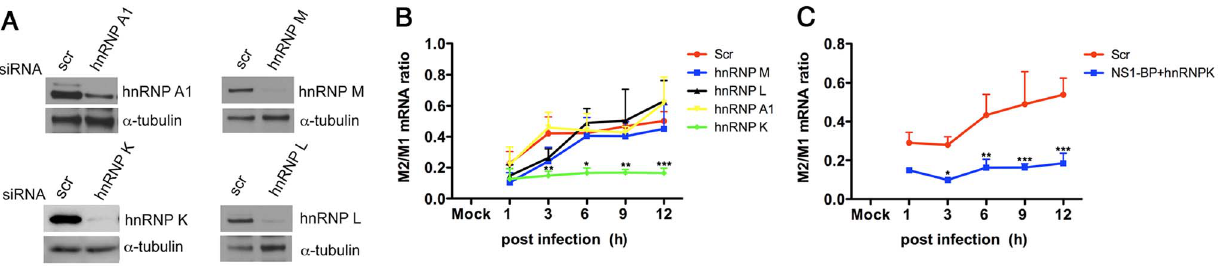
Figure 4. hnRNP K regulates M1 mRNA splicing. (A) Cell extracts from A549 cells transfected with non-targeting siRNAs or siRNAs that target various indicated hnRNPs for 48 h were subjected to immunoblot analysis with antibodies specific to each hnRNP. (B and C) A549 cells were transfected as in B and then infected with A/WSN/33 at MOI 2 for the indicated time points. In C, NS1-BP and hnRNP K were simultaneously knocked down. Total RNA was isolated at each depicted time point and analyzed by real-time RT-PCR with primers specific to M1 and M2 mRNAs. M2/M1 mRNA ratios are shown. Error bars represent mean 6 SD (n=3). *p , 0.05, **p , 0.01, ***p , 0.001.